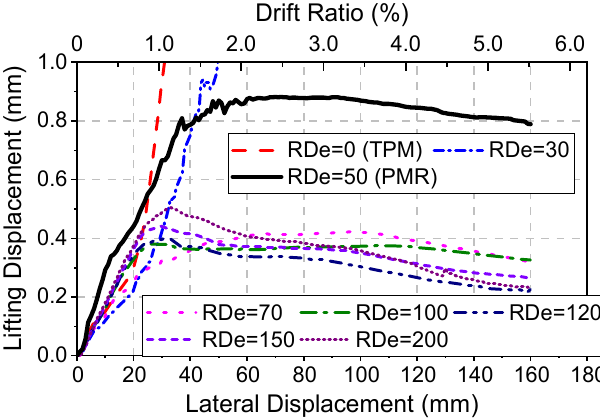
Figure 18. Lifting displacement with different recess depths.